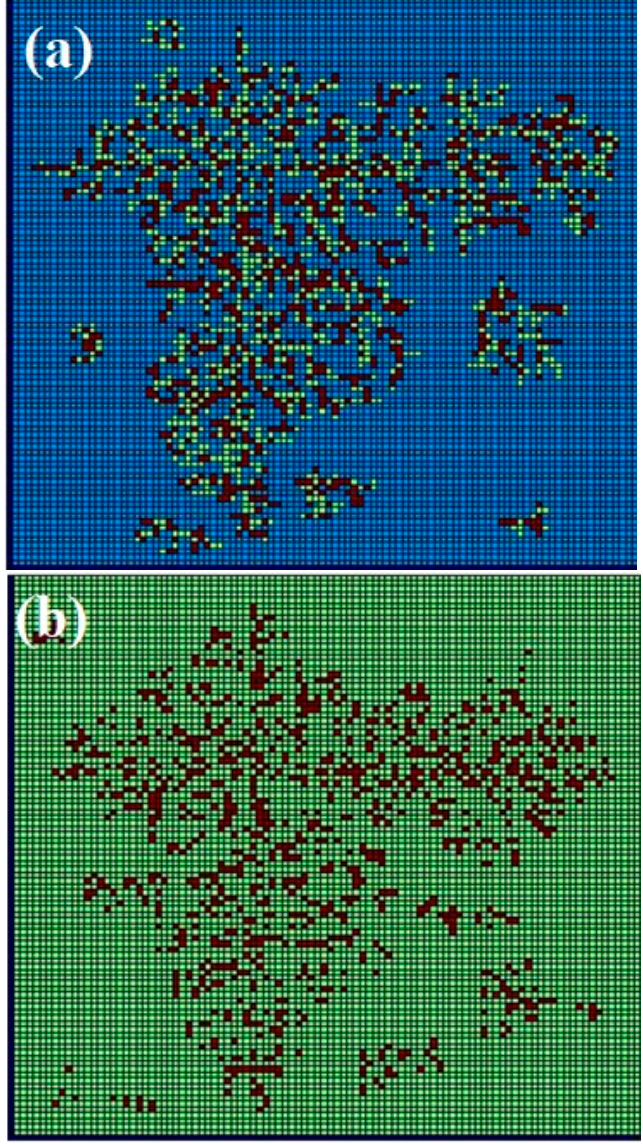
Figure 5. Model representations of the evolution of copper-containing structures: (a) S_350 and (b) S_500 (red—copper-containing particles, green—organic matrix, blue—background).